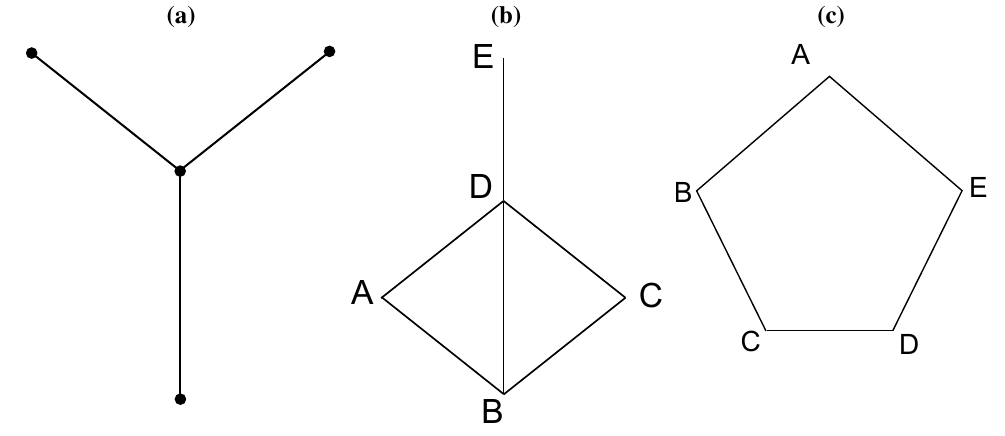
Figure 1. There exists polynomial solutions to the weighted clique cover problem (WCCP) for claw-free perfect graphs. ( a ) Illustration of a claw; ( b ) an example of a perfect graph; ( c ) an example of an imperfect